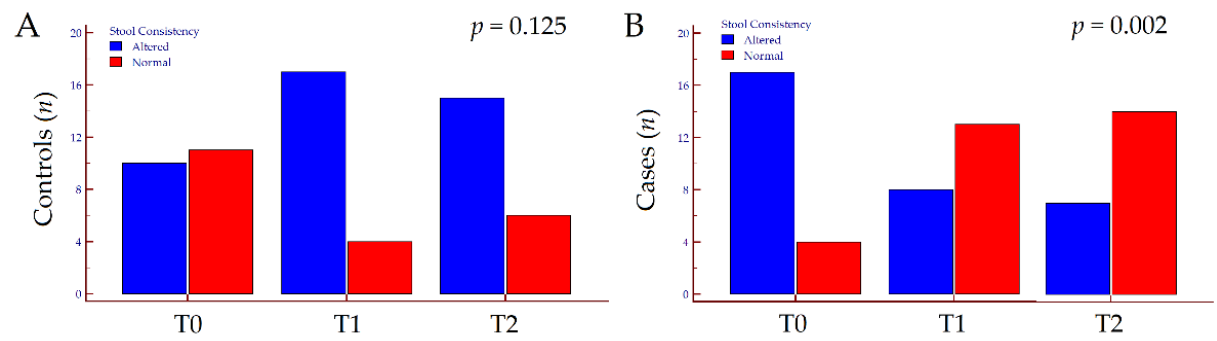
Figure 3. Variation of stool consistency in patients treated with mesalamine only ( A ) and those treated with mesalamine plus FEEDColon ® ( B ) from T0 to T2 according to treatment. p values were calculated by McNemar test. Abbreviations: n , number; T, timepoint.